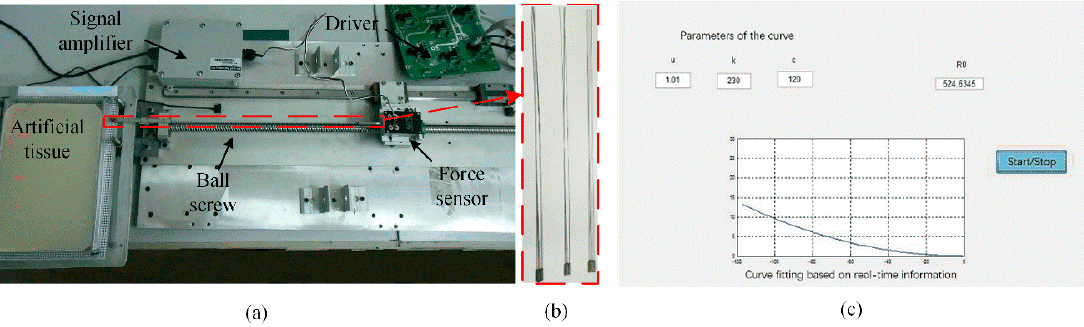
Figure 1. The experiment setup. ( a ) The hardware configuration; ( b ) The flexible needles used; and ( c ) The GUI. The